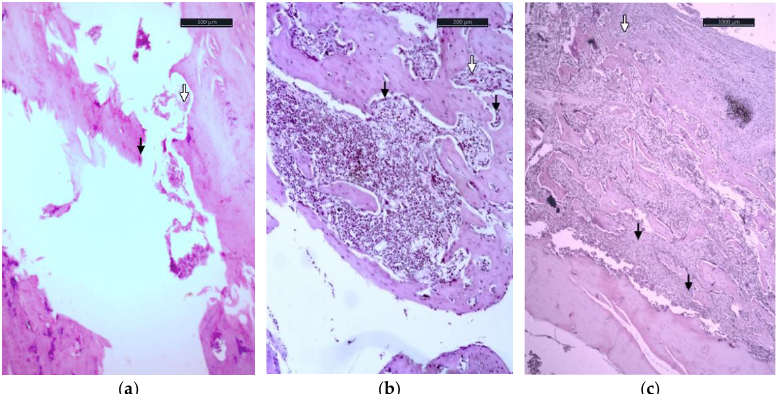
Figure 1. Bone tissue of a rat in the area of a hip shaft fracture on the 14th day of the experiment: ( a ) rat without an implant; HE ×400; ( b ) rat with magnesium implants coated with hydroxyapatite; HE ×400; ( c ) rat with a magnesium implant coated with hydroxyapatite and sealed with polytetraflu- oroethylene (the arrow marks the focus of perichondral osteogenesis; the medullary part of the bone is filled with fibroreticular tissue → ), empty Gauship lacunae containing osteoclasts (marked with an arrow ). Staining with hematoxylin and eosin at constant magnification HE ×100. In the third group of rats, the cortical part of the bone in the damaged area was filled with cartilage (Figure 1c). Focuses of perichondral osteogenesis were noted in the en- dosteal part of the defect (Figure 1c).